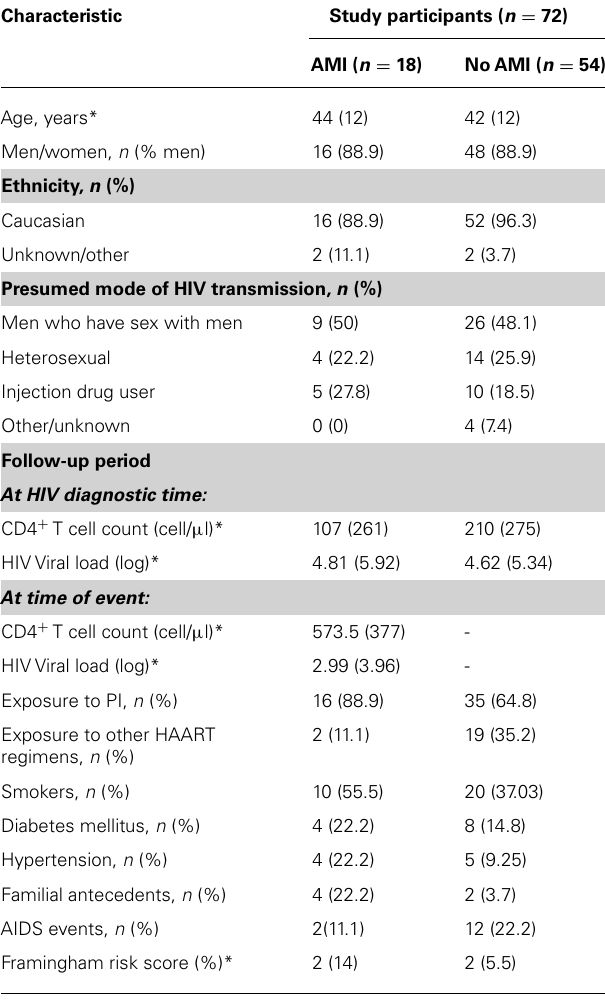
Table 1 | Baseline characteristics of the study participants. Table 2 | Multivariate analysis through logistic regression including all genetic and non-genetic